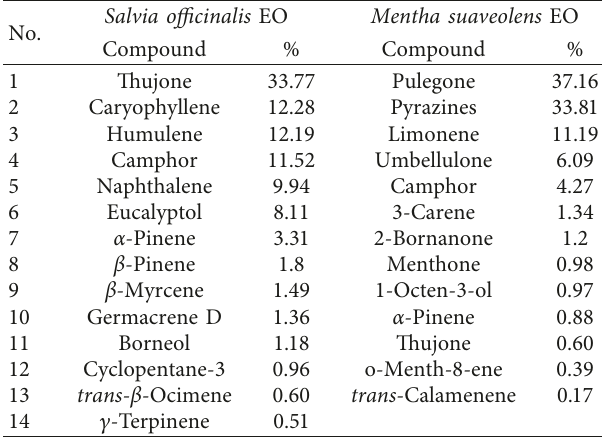
Table 5: Chemical composition of the essential oils (EOs) of Salvia officinalis and Mentha suaveolens